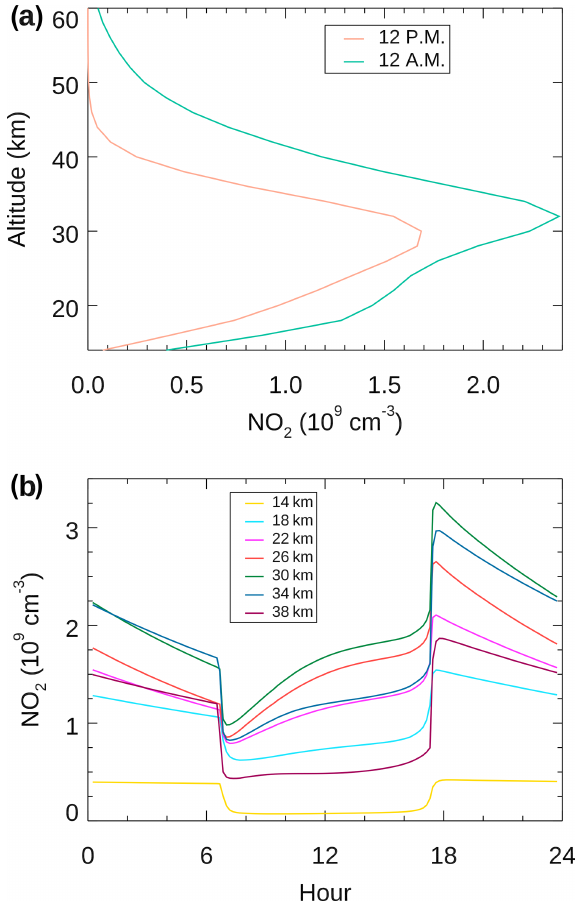
Figure 5. Simulated vertical NO 2 concentration. (a) The simulated NO 2 vertical concentration between 14–38km at 00:00PST (green) and 12:00PST (orange) corresponding to 27 October in the 1-D photochemical model. (b) Same as (a) except the simulated NO 2 variation over the 24h at selected altitudes.